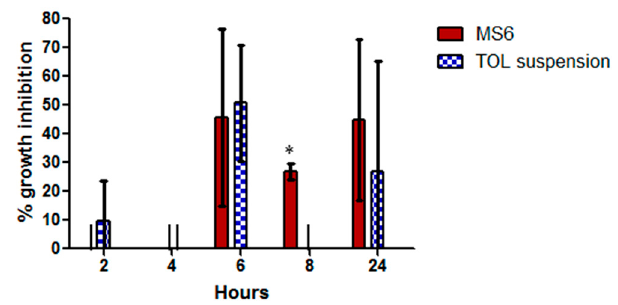
Figure 11. In vivo percentage growth inhibition of MS6 (treatment A) compared to TOL suspension (treatment B) on Aspergillus niger (ATCC32656). * Indicates statistically significant difference between the columns applying one-way ANOVA test ( p < 0.05, n = 3).